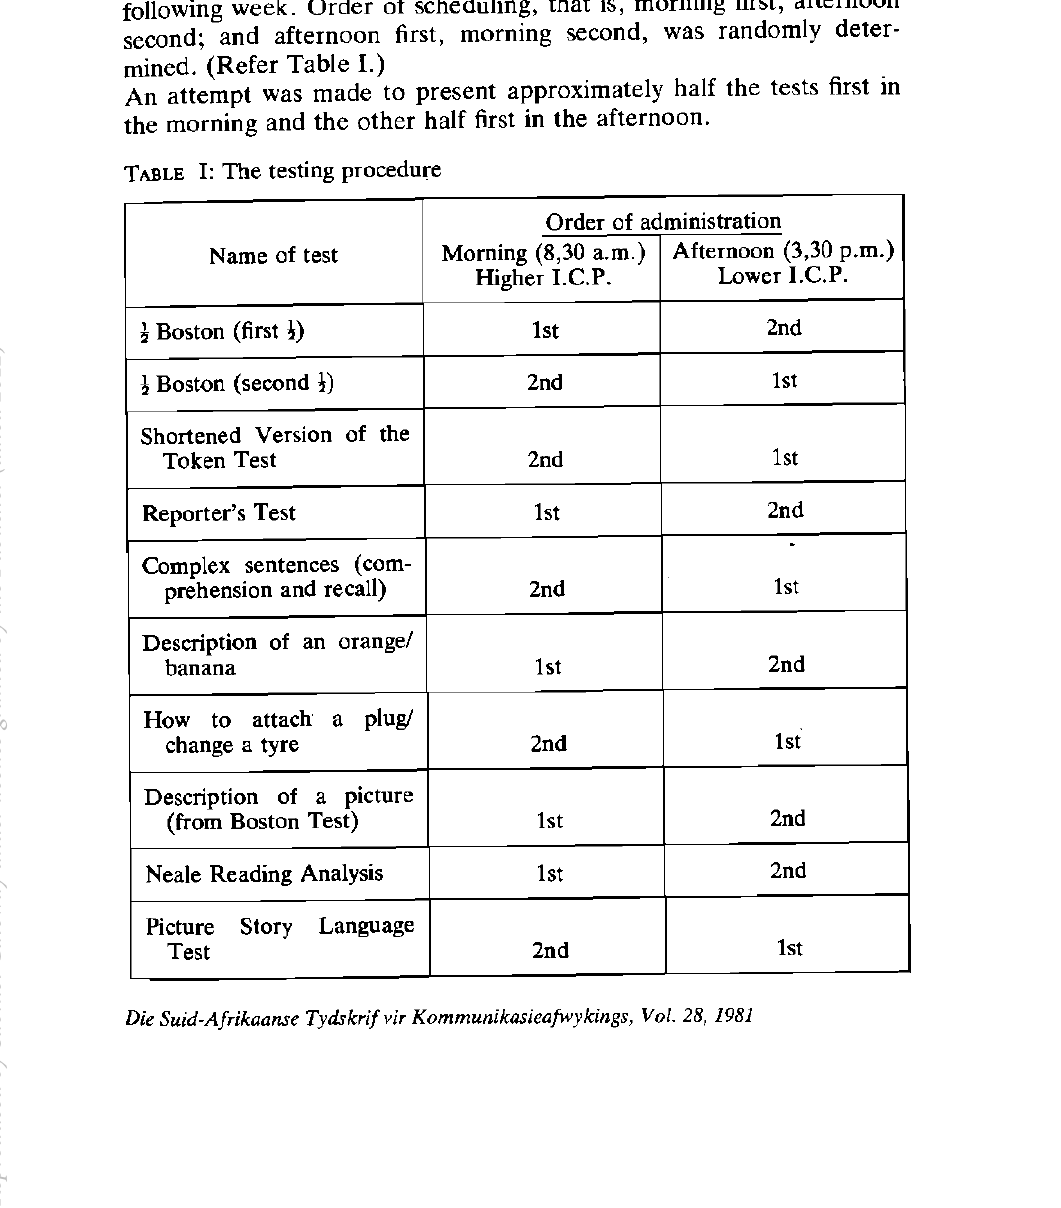
TABLE I: The testing procedure